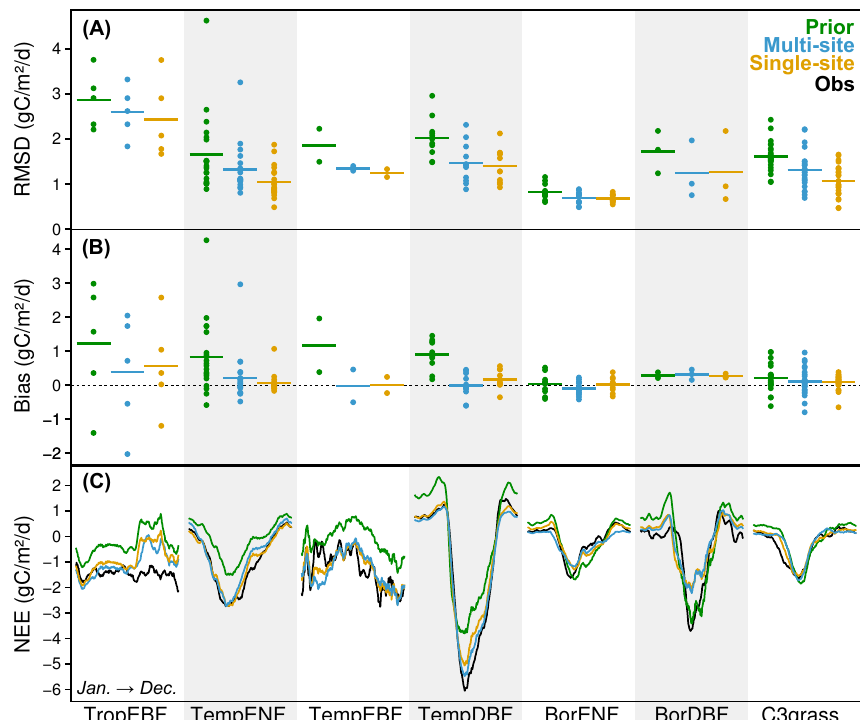
Figure 1. Model–data (a) RMSD and (b) bias for the daily NEE time series at each site (filled circles), grouped and averaged by PFT (horizontal bars), in three cases: prior model (green), multisite optimization (blue) and single-site optimization (orange). (c) PFT-averaged mean seasonal cycle of NEE, for the training observations (black) and the three aforementioned cases, smoothed with a 15-day moving- average